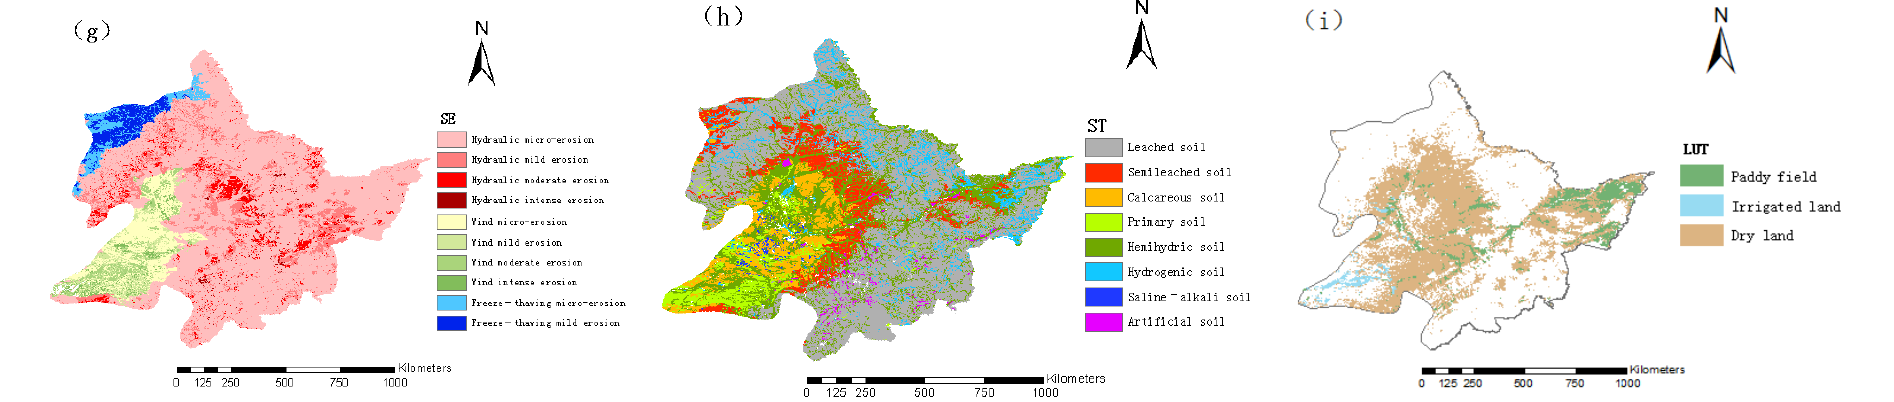
Figure 3. The spatial distribution of influencing factors in the study area. ( a ) The spatial distribution of mean annual temperature; ( b ) the spatial distribution of mean annual precipitation; ( c ) the spatial distribution of digital elevation model; ( d ) the spatial distribution of pixelized population map; ( e ) the spatial distribution of pixelized gross domestic product map; ( f ) the spatial distribution of geomorphic types; ( g ) the spatial distribution of soil erosion data; ( h ) the spatial distribution of soil type; ( i ) the spatial distribution of land use type.